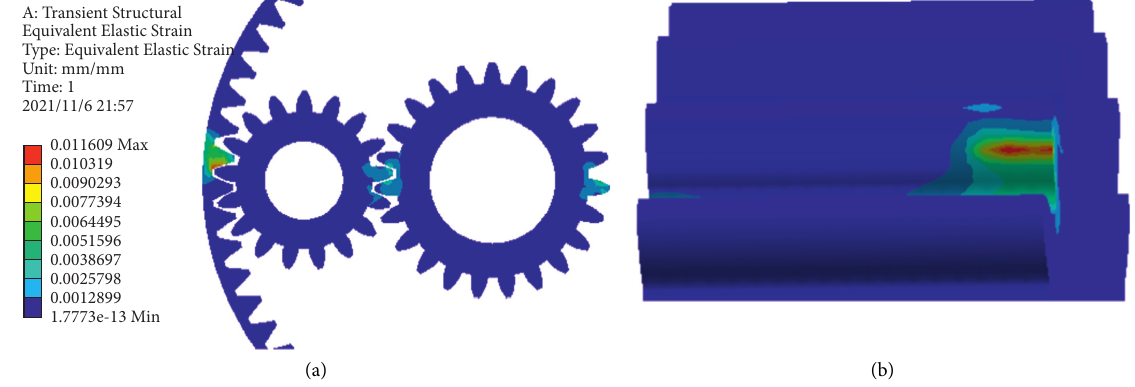
Figure 15: Equivalent strain program of the planetary gear train. (a) Equivalent strain program. (b) Program of sun gear strain.